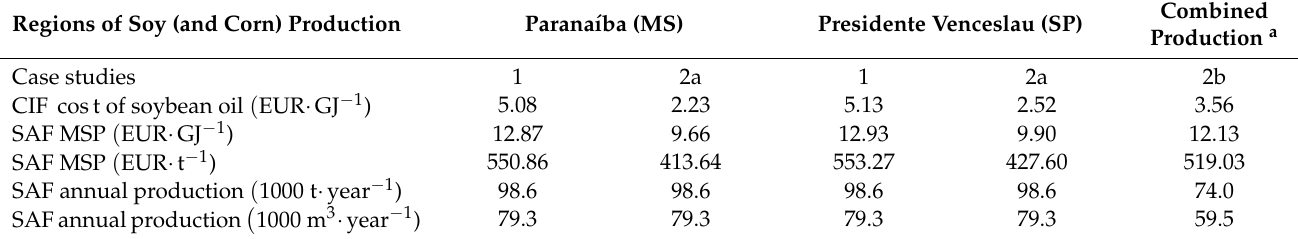
Table 5. Summary of results: SAF production based on HEFA-SPK, using soybean oil produced in two self-dedicated